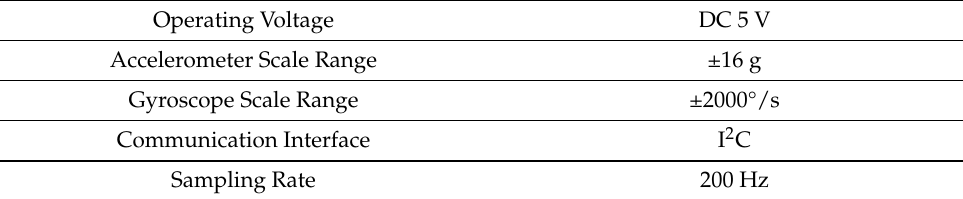
Table 1. Specifications of MPU9250 IMU.